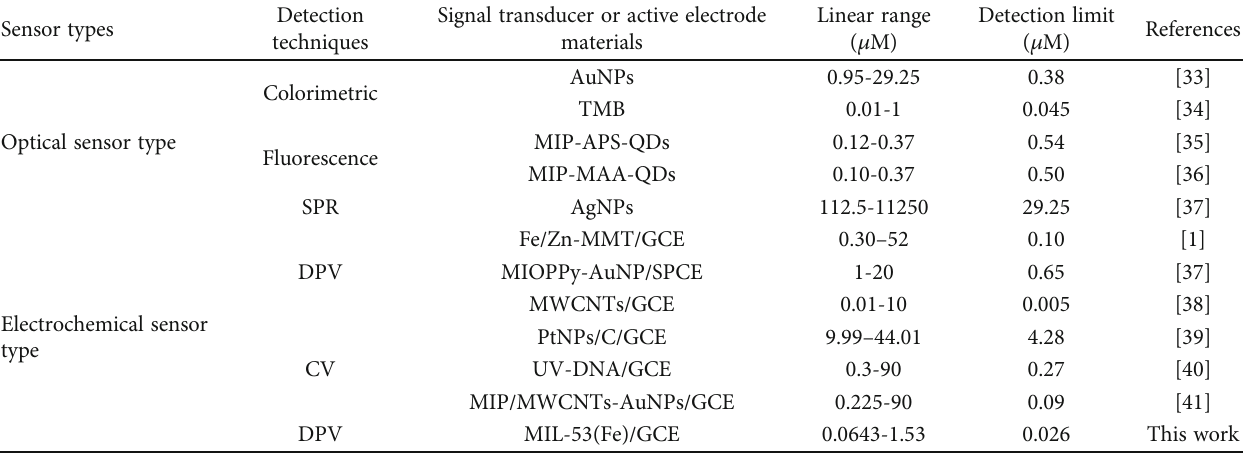
Figure 5: (a) DPV of tetracycline with di ff erent concentrations in 1M H tetracycline Table 1: Summary of the tetracycline detecting performance between di ff erent sensors.